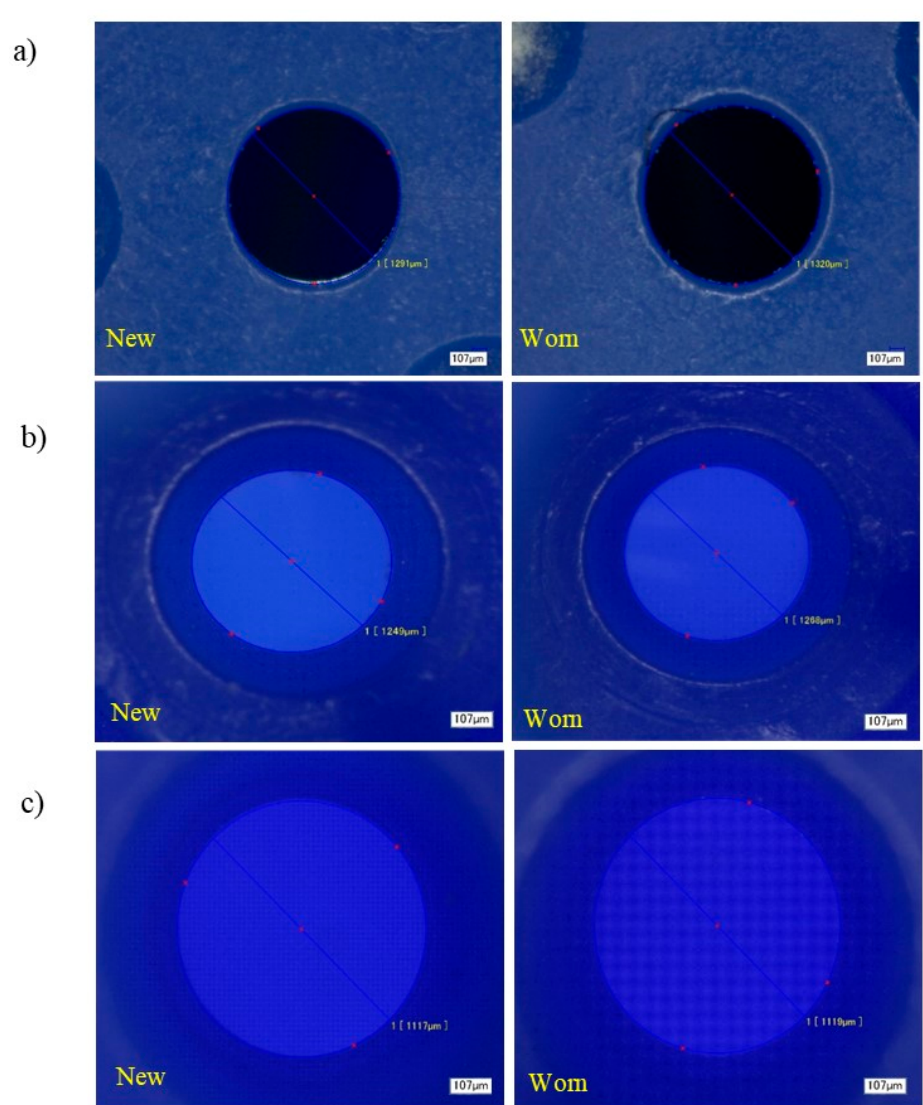
Figure 5. Photographs of the nozzle pre-orifice (from inside the nozzle body) before (New) and after the accelerated wear test (Worn): ( a ) DG nozzle, ( b ) TT nozzle, ( c ) TTj60 nozzle.